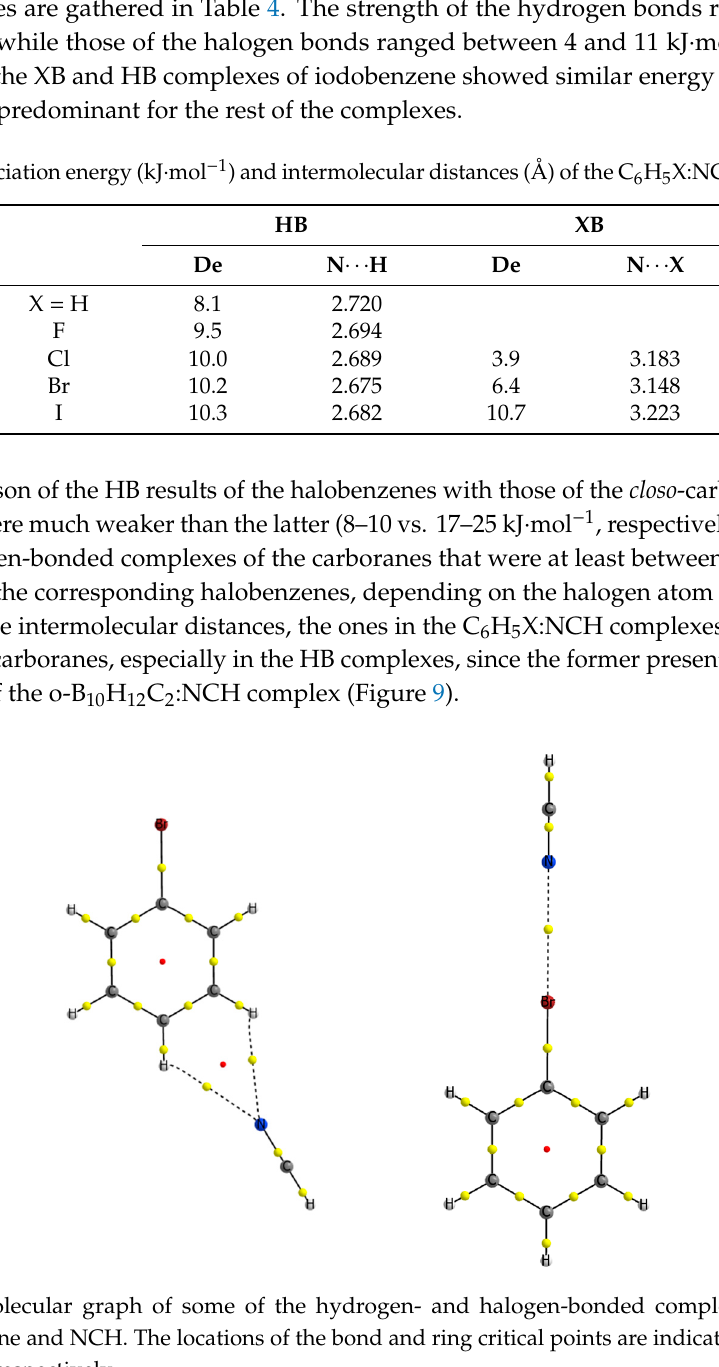
Table 4. Dissociation energy (kJ · mol − 1 ) and intermolecular distances (Å) of the C 6 H 5 X:NCH complexes.